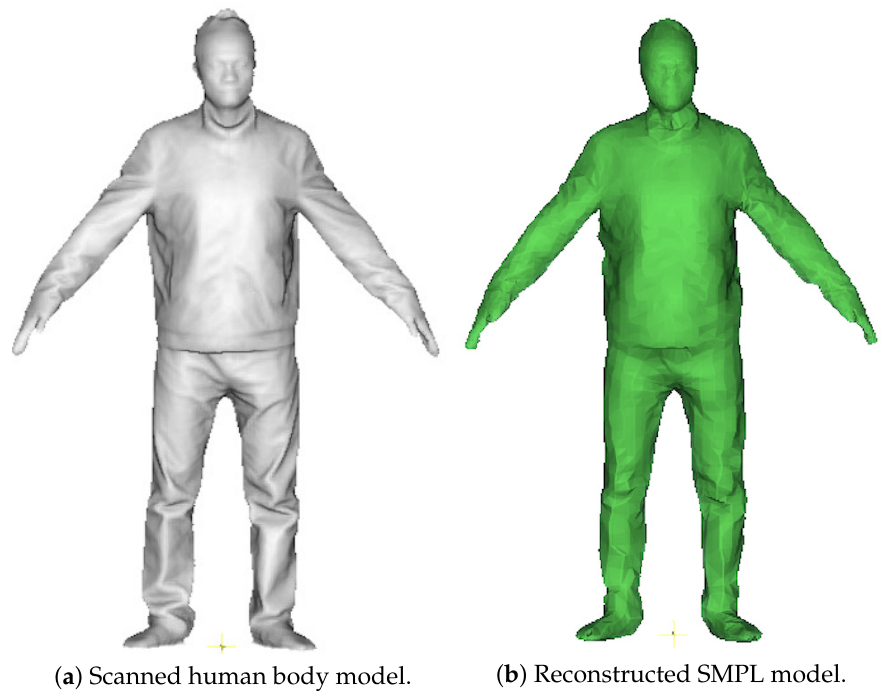
Figure 3. Personalized SMPL model for 3D posture